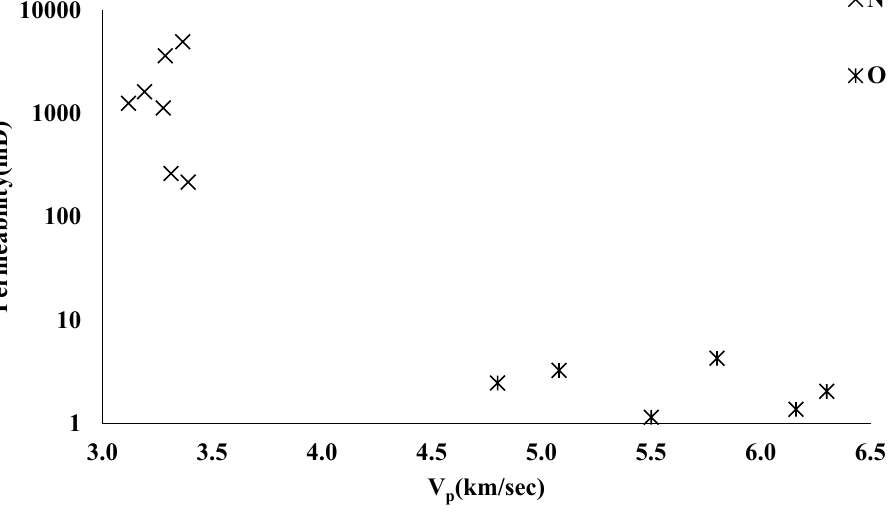
Fig. 8 V p versus permeability as reported by different